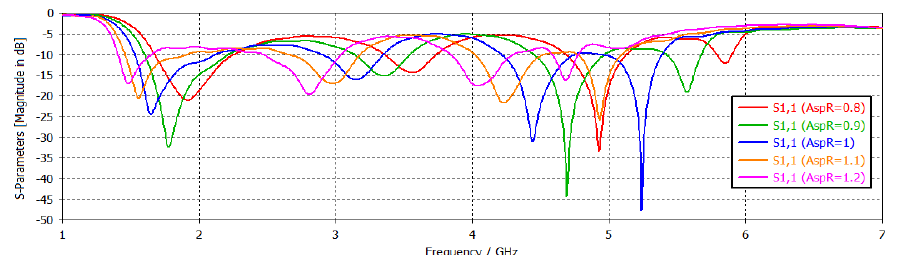
Figure 4. The simulated input reflection coefficient of the antenna for different values of ( AspR)